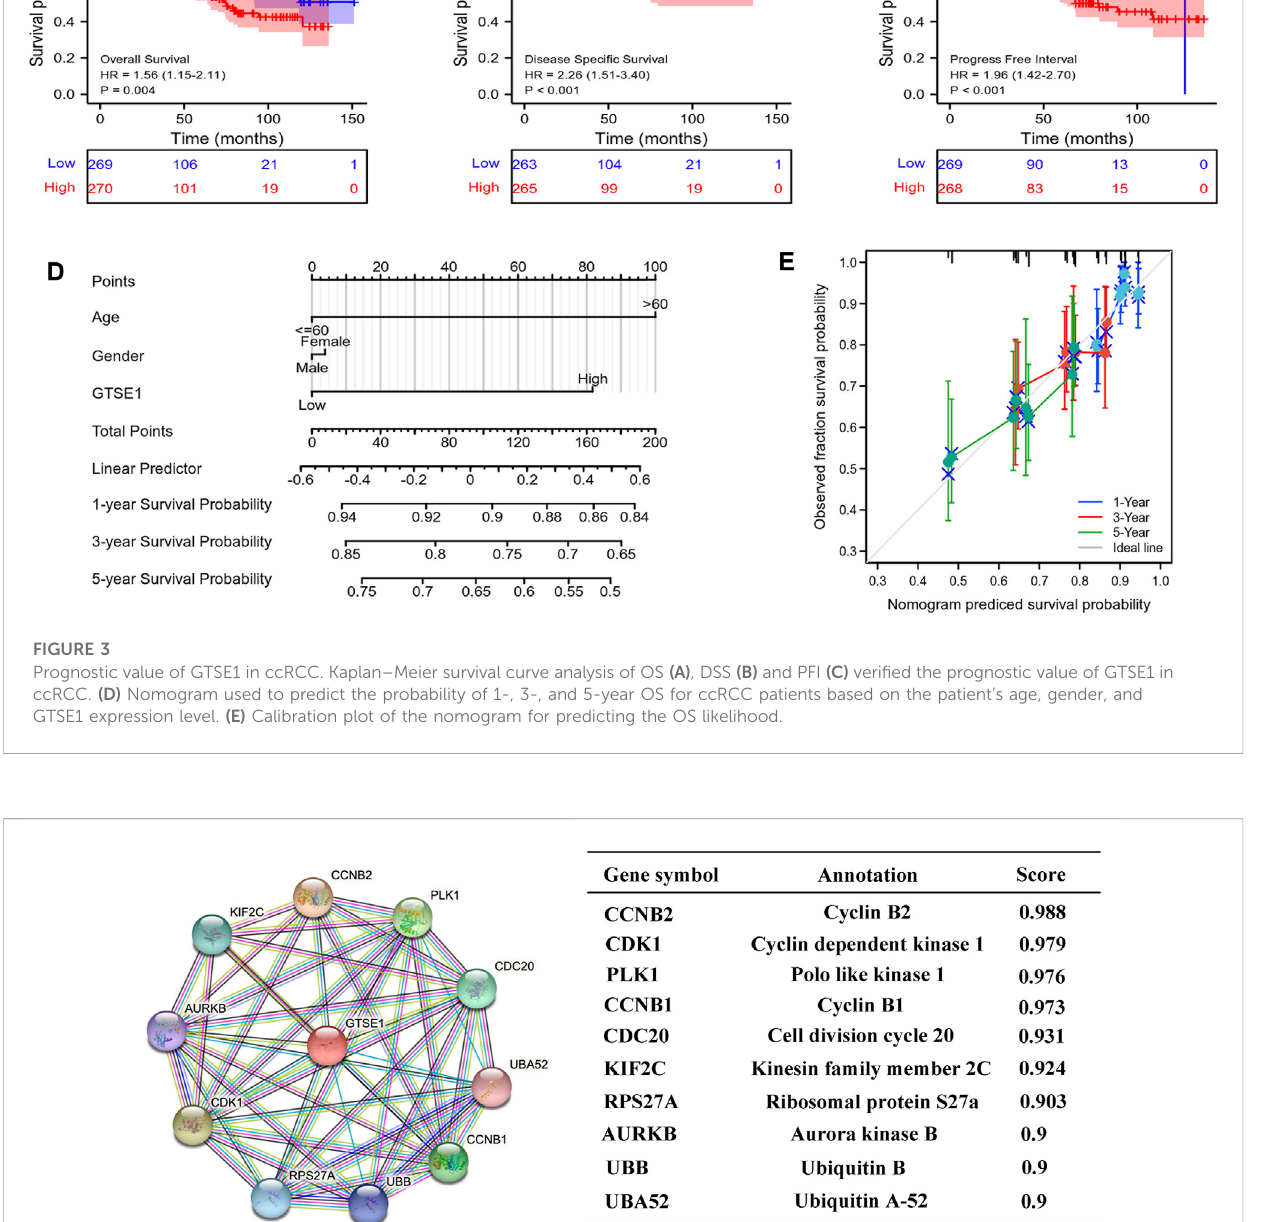
expression of GTSE1) based on the TCGA-KIRC cohort. The results suggested that patients with high GTSE1 expression had higher immune in fi ltration levels of T cells CD8, T cells follicular helper, T cells regulatory (Tregs), Monocytes, Macrophages M0, Macrophages M1, Macrophages M2, Dendritic cells resting, and